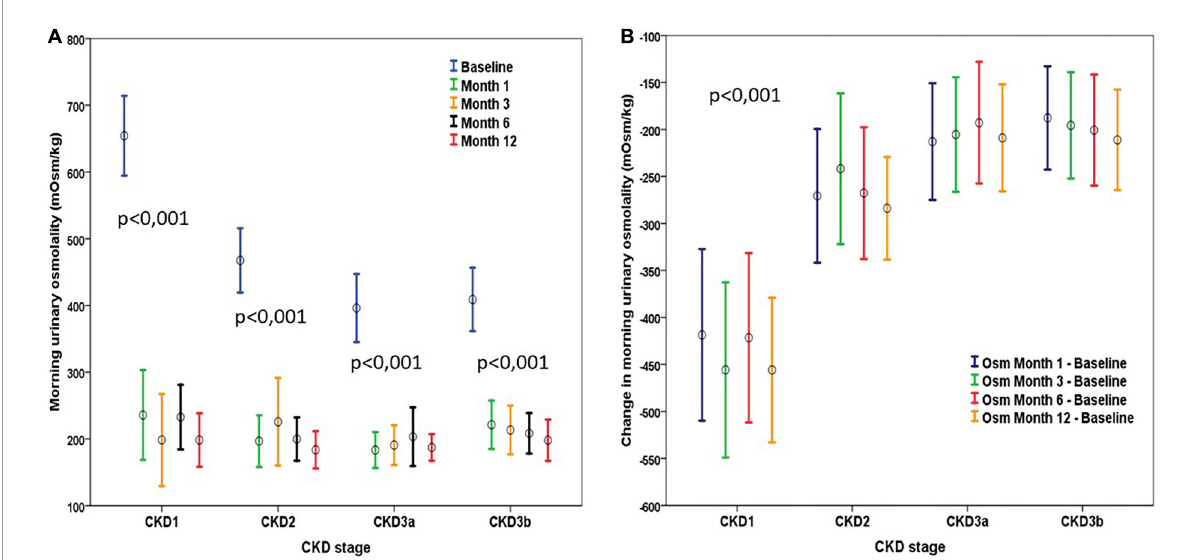
FIGURE6 (A) Evolution of urinary osmolality according to the stage of CKD. There was a significant decrease in all stages from the first month, with no subsequent significant changes in any stage. (B) Change in urinary osmolality observed after tolvaptan according to CKD stage. Changes observed were stable during the first year of treatment within each class considered. The decrease in urinary osmolality was greater in the stages with a higher baseline GFR rate. Mean values and mean standard error are represented in both